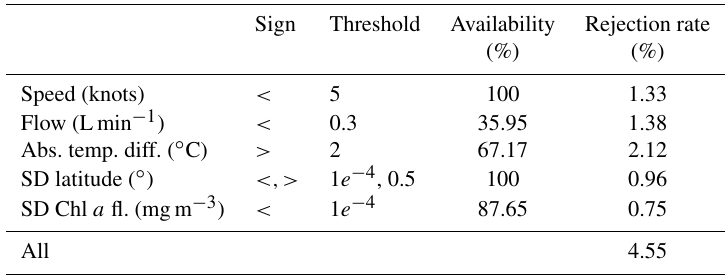
Table 1. Quality control flag definitions and statistics. Observations were omitted if any of the flags exceeded the respective threshold. Absolute temperature difference is measured between the water intake and the flow-through sensors. Availability and rejection rates were calculated relative to the total number of observations. SD denotes standard deviation.